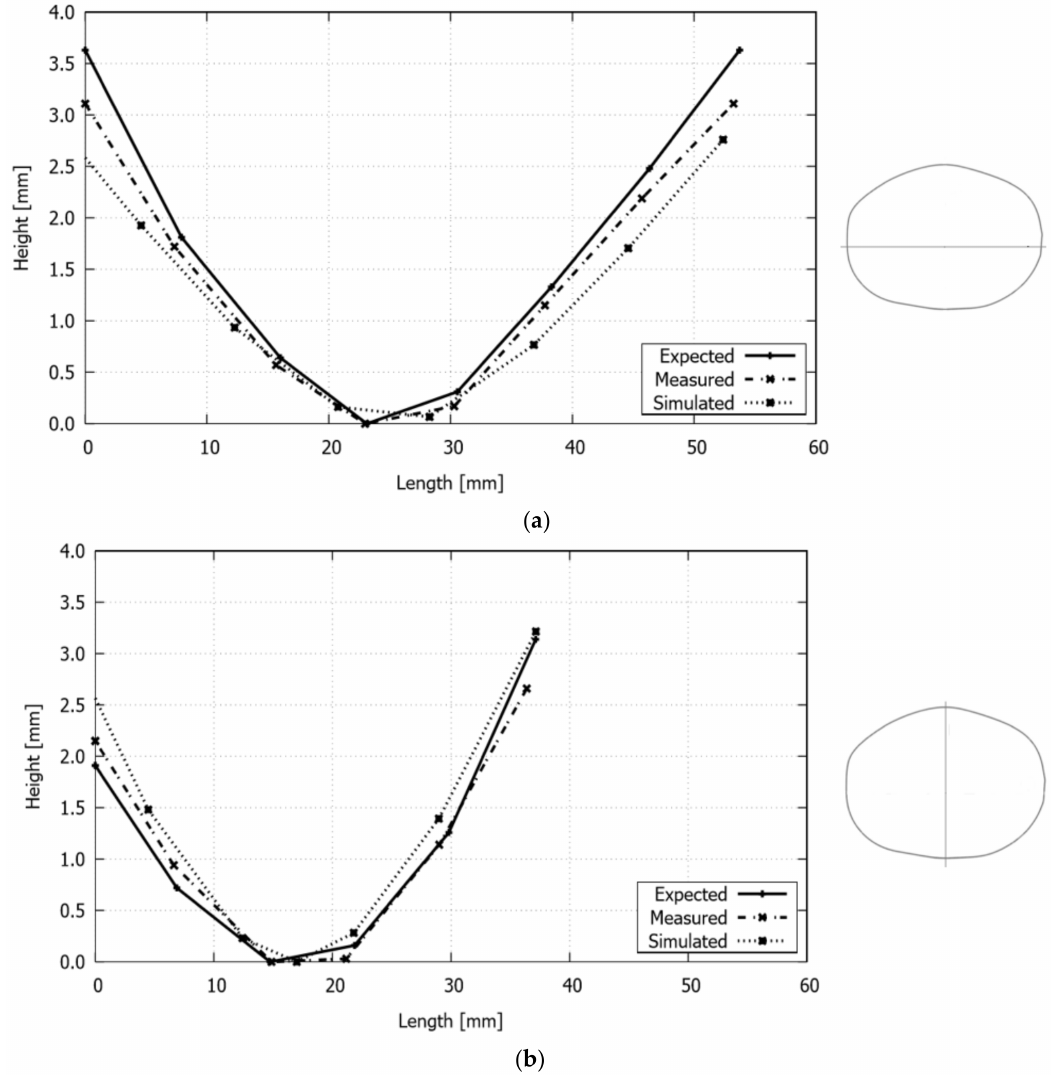
Figure 14. Single piecewise linear scanning paths: final deformed configuration of the cranial prosthesis along its ( a ) major and ( b ) minor